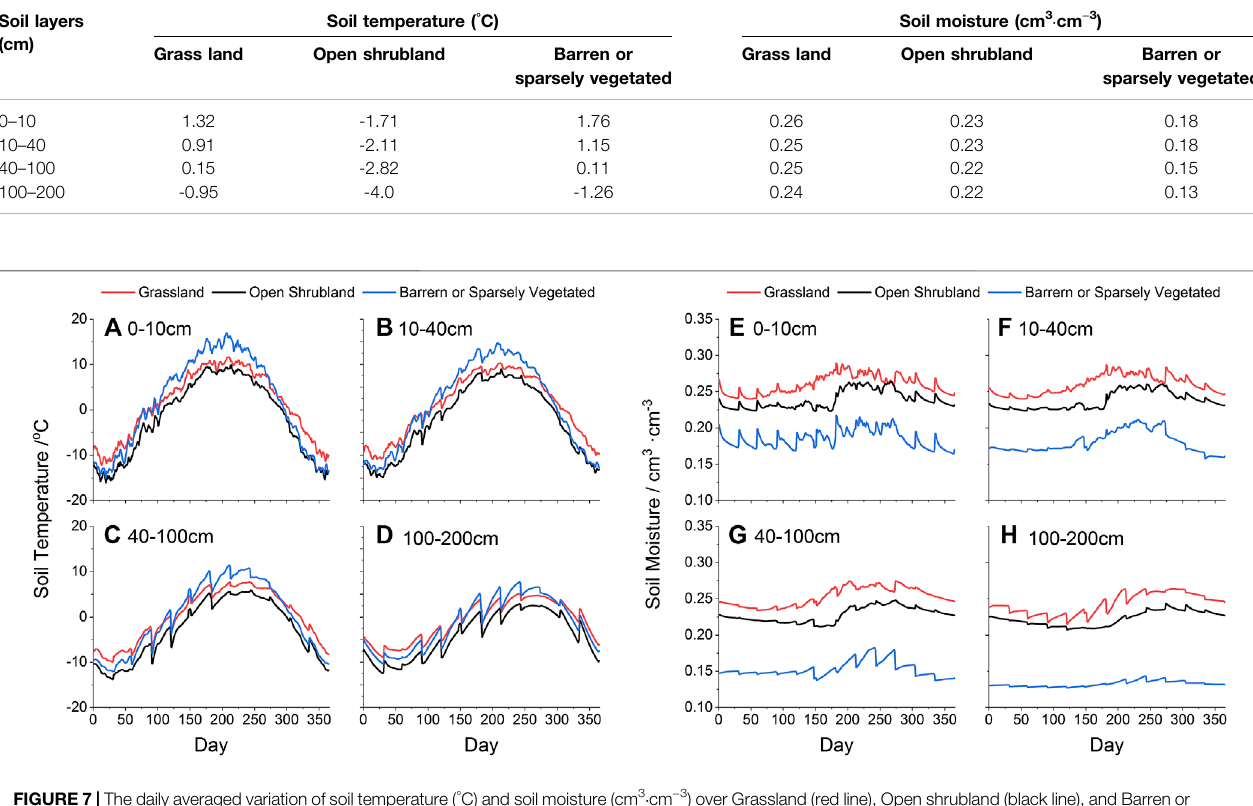
Frontiers in Earth Science |